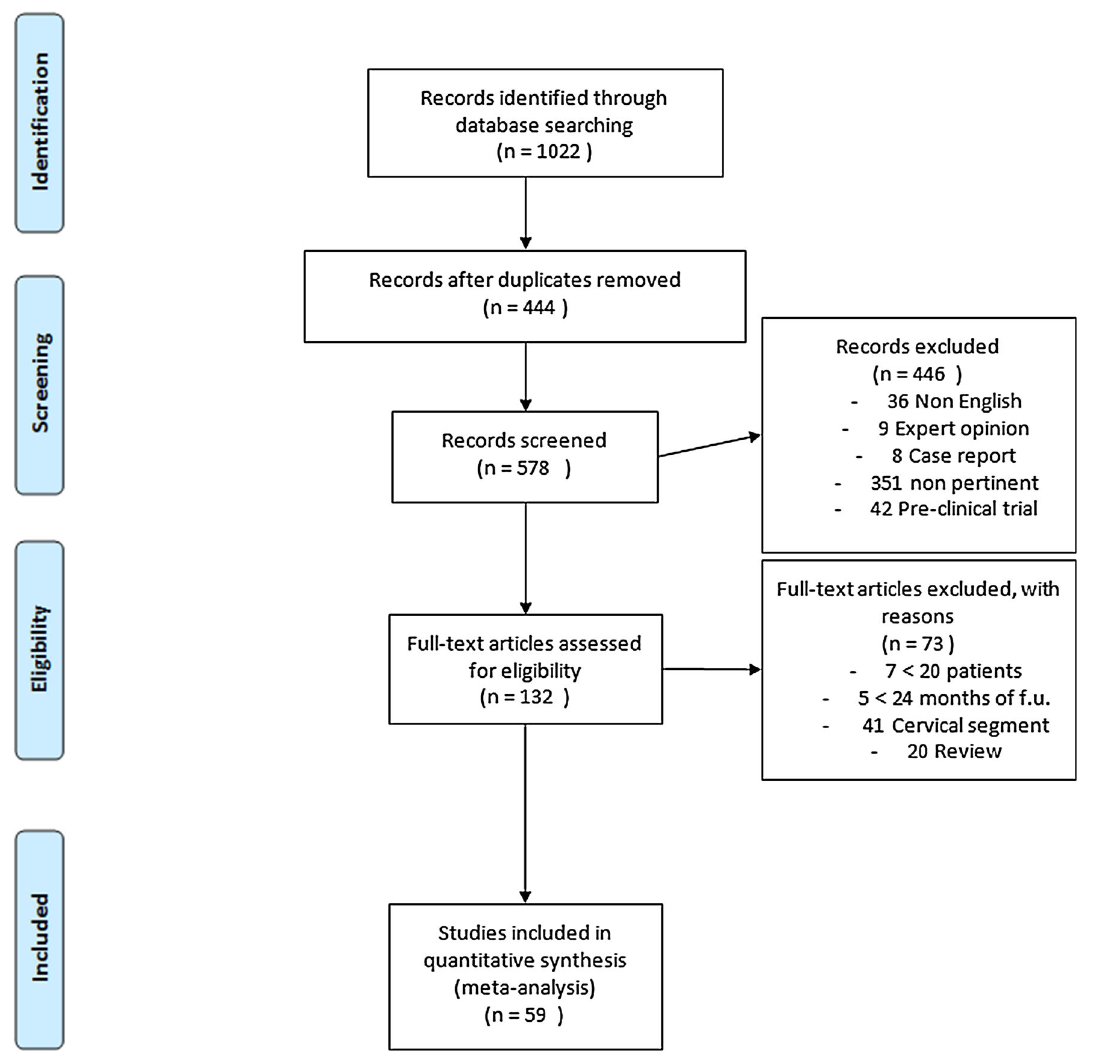
Fig. 1 The PRISMA 2009 flow diagram illustrates the review process, the number of the studies identified, included and